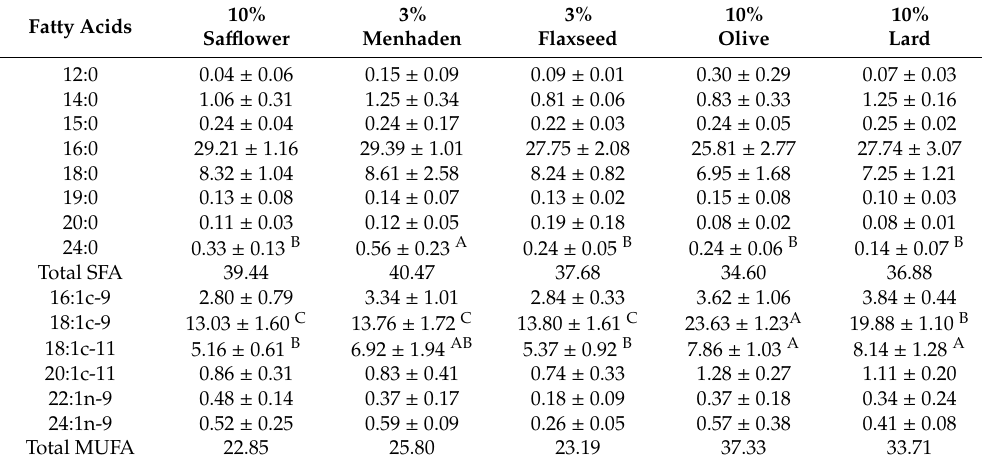
Table 2. Percent composition of fatty acids in PC fraction of mammary tumour phospholipids. Fatty